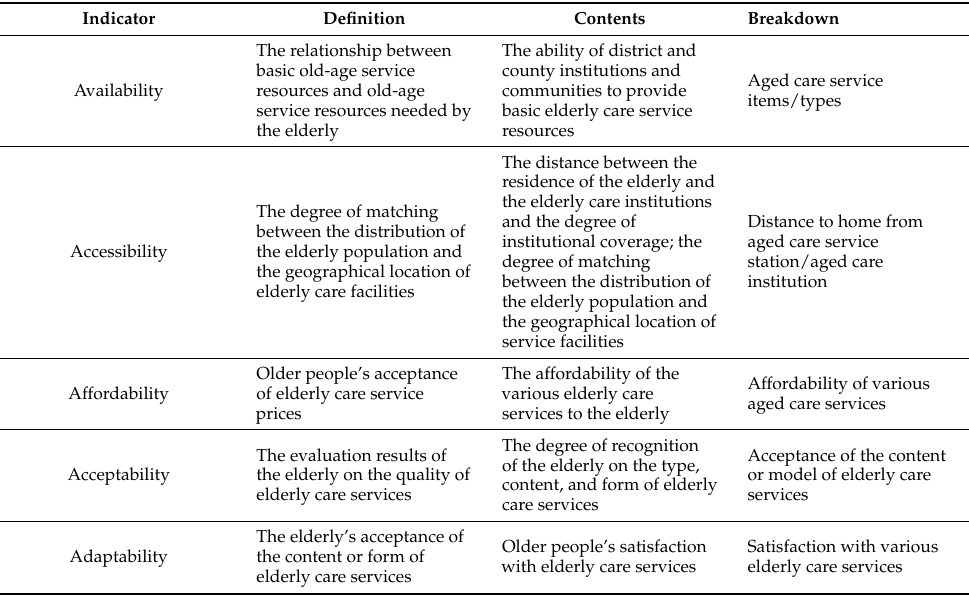
Table 2. Conceptual model of accessibility of basic pension